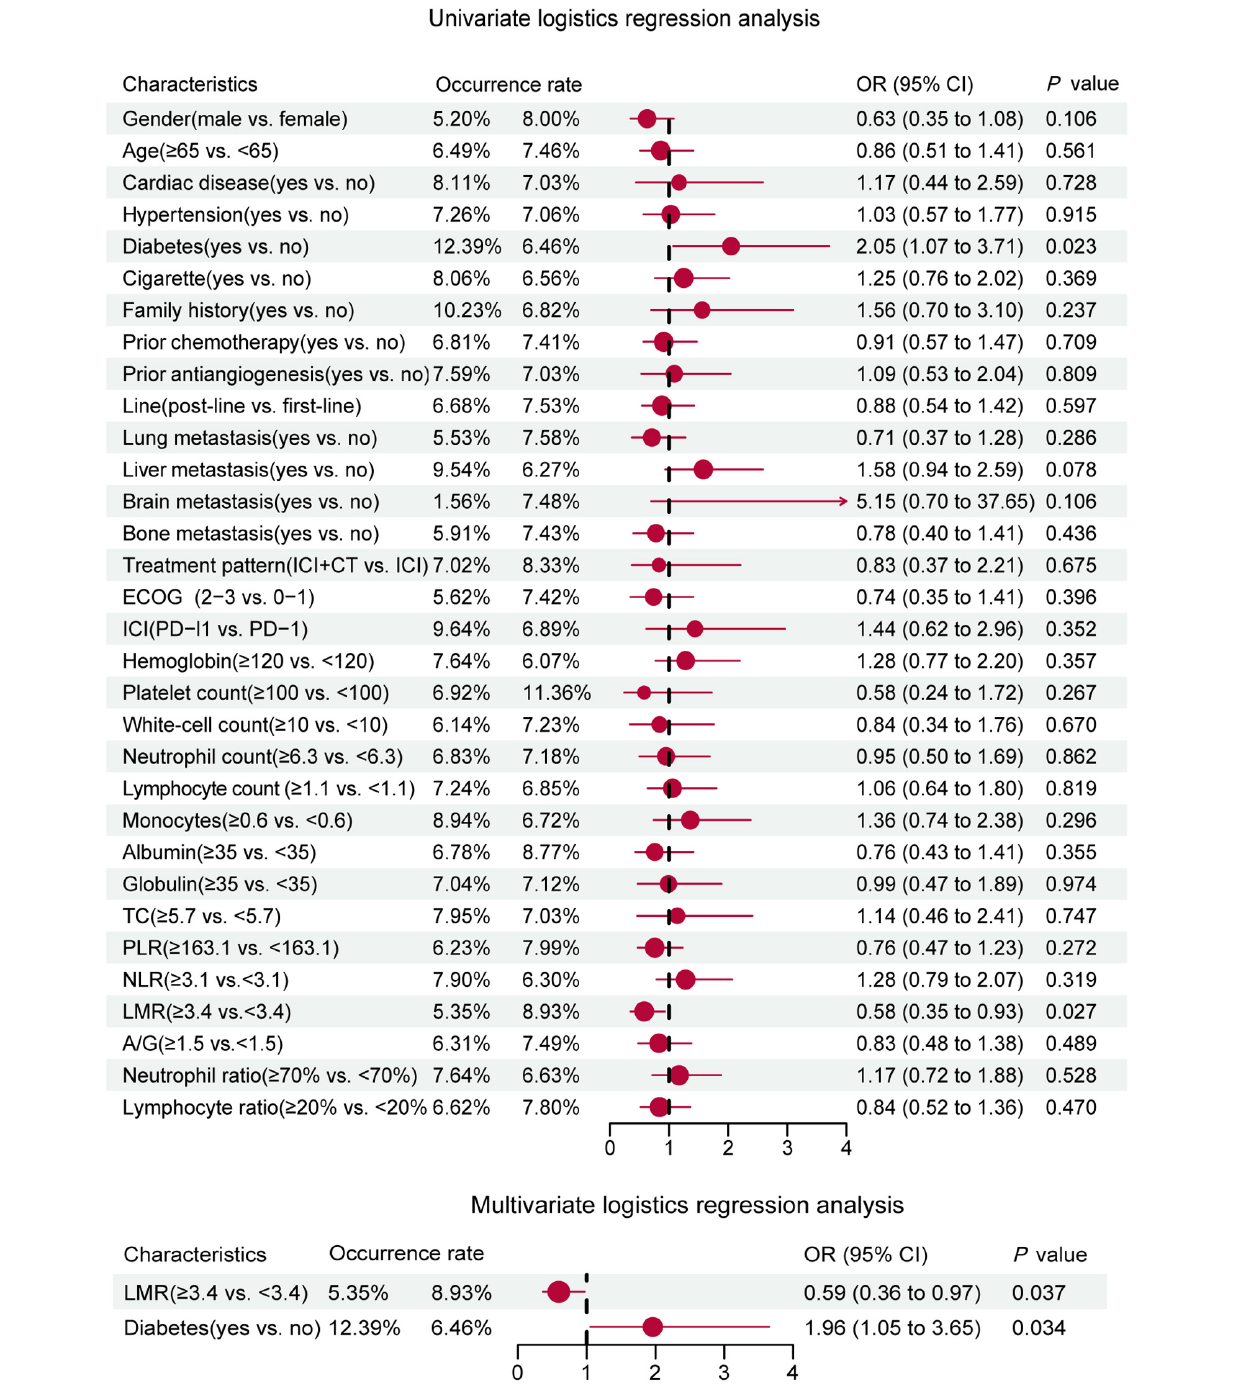
FIGURE 1 | Univariate and multivariate logistic regression forest plot of baseline characteristics and incidence of cardiotoxicity in the whole